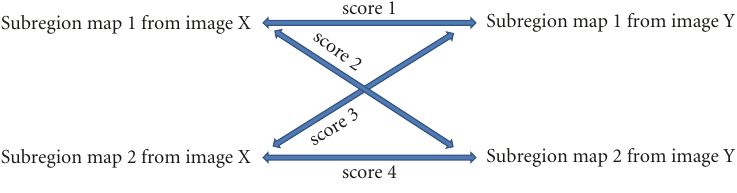
Figure 8: Subregion matching between two iris images.